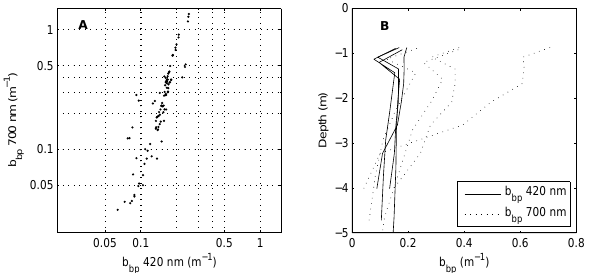
Fig. 9. R rs modelled at various concentrations of Chl a showing the difference between vacuolate (solid lines) and non-vacuolate (dotted lines) populations of M. aeruginosa . Vacuolate cells were modelled with shell 1+ (cid:15) of 1.12 and V g =50%. Non-vacuolate cells were homogeneous cells with 1+ (cid:15) of 1.080. The values for a tr (440) and a g (440) were constant at 0.5 and 1.5m − 1 , respectively. For more details, see the